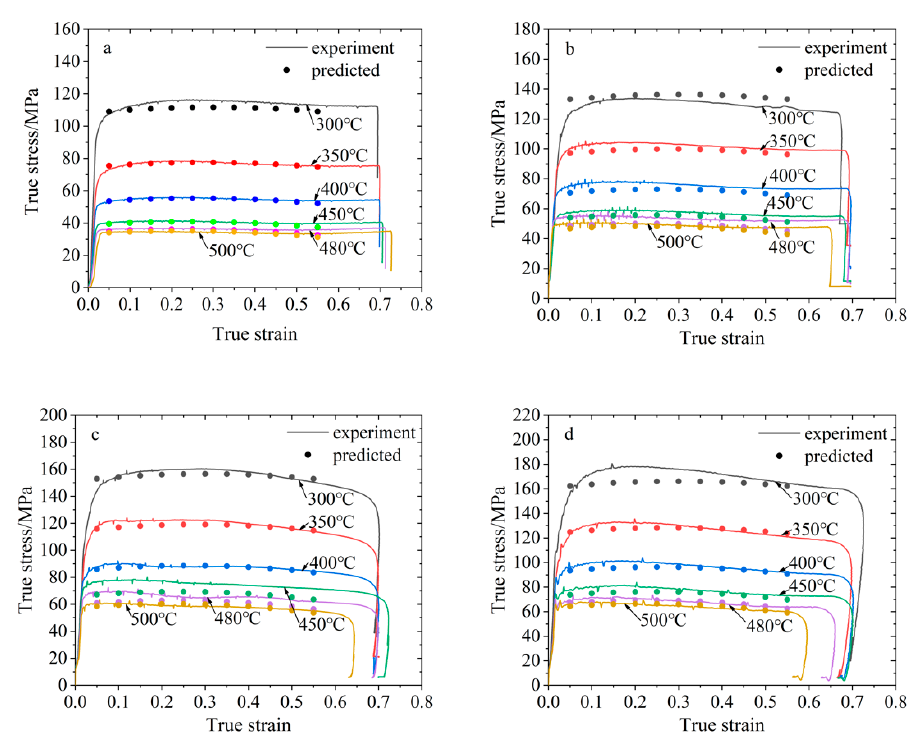
Figure 14. The perdition results based on the exponential constitutive model: ( a ) 0.1 s − 1 ; ( b ) 1 s − 1 ; ( c ) 5 s − 1 ; ( d ) 10 s − 1 .